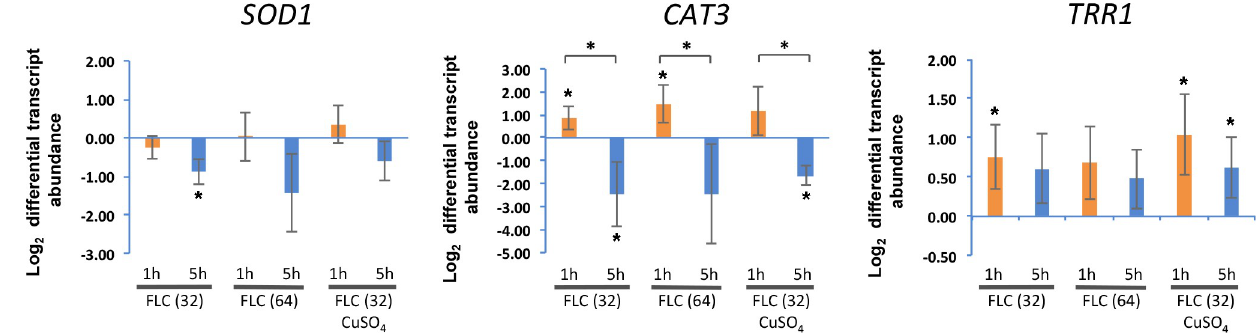
Fig 2. The effects of FLC on transcription of genes encoding copper/zinc superoxide dismutase ( SOD1 ), catalase ( CAT3 ) and thioredoxin reductase ( TRR1 ). Exponentially grown cultures of C . neoformans (H99) were resuspended in YPD medium supplemented with FLC (32 or 64 μ g/ml), CuSO 4 (1 mM) with FLC (32 μ g/ml), or 0.1% (v/v) DMSO (as control) and grown at 24˚C for 1 or 5 hours prior to total RNA extraction. Transcript abundance was analyzed by quantitative PCR. Star indicates statistical significance (p <